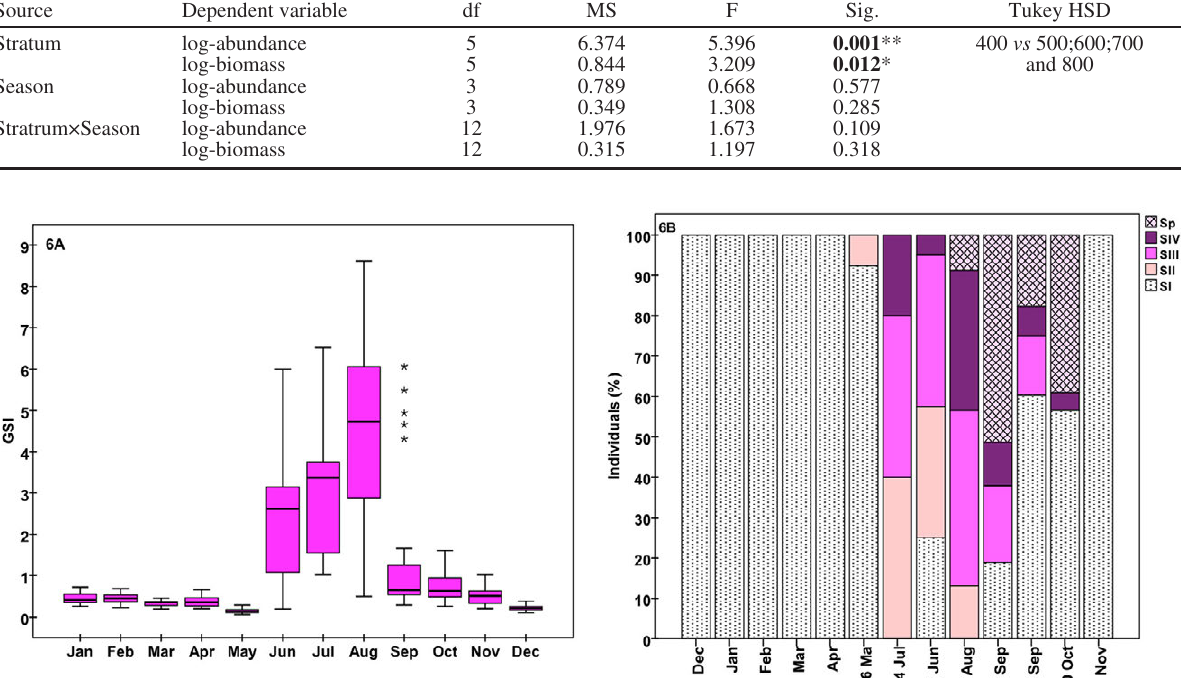
Table 3. – Results of the two-way MANOVA for significant testing in log-transformed abundance (n km –2 ) and biomass (kg km –2 ) of A. antennatus between strata and seasons; * p<0.05; ** p<0.01. Source